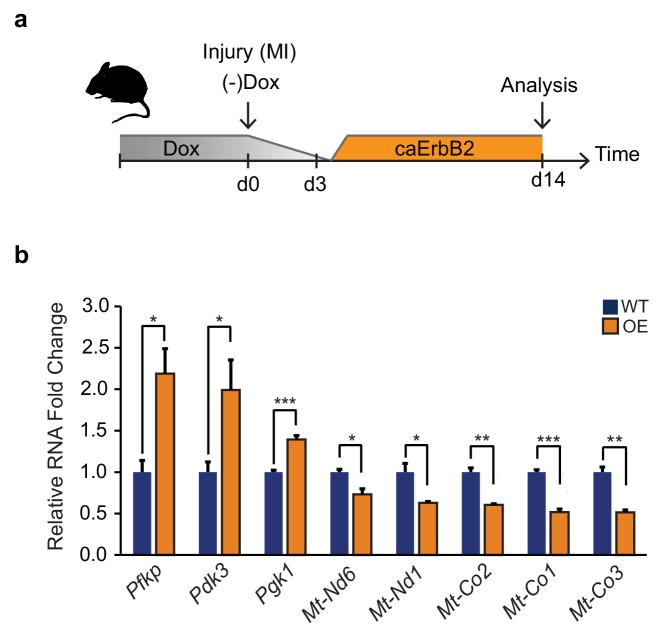
Activation of ErbB2 signaling in murine MI model induces glycolytic gene expression while repressing mitochondrial genes.(a) Cartoon showing experimental procedure. Myocardial infarction (MI) was induced by left anterior descending coronary artery ligation at the same day when Dox was removed to induce cardiomyocyte specific caErbB2 overexpression (OE). Whole hearts where isolated for mRNA extraction 14 days after the MI and caErbB2 induction. (b) qPCR results with relative mRNA fold changes comparing wild type (WT, blue bars) with caErbB2 OE (OE, orange bars). Note the significant upregulation of glycolytic genes (Pfkp, Pdk3 and Pgk1) and significant downregulation of genes transcribed from the mitochondrial DNA (Mt-Nd1, Mt-Co2, Mt-Co1 and Mt-Co3). Bars represent mean values and error bars represent standard deviation. *p<0,05; **p<0,01; ***p<0001.